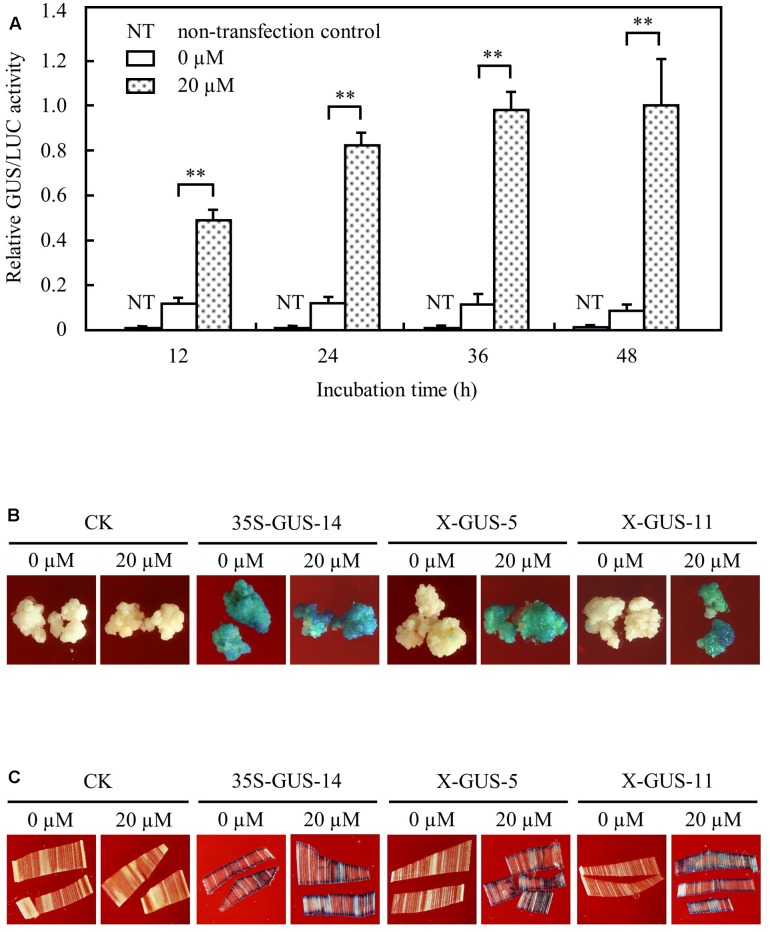
XVE-controlled GUS expression in rice protoplast, calli, and leaf tissues upon direct contact with estradiol. (A) Transient expression assay of XVE-controlled GUS expression in rice protoplasts. Protoplasts transfected with construct pUX-GUS were treated with 0 or 20 μM estradiol for 12, 24, 36, and 48 h, respectively. GUS expressions are represented as relative GUS/LUC activity. ∗∗P < 0.01, t-test. (B) GUS staining of rice calli induced with 0 or 20 μM estradiol. CK, non-transgenic wild type control; 35S-GUS-14, line #14 of rice calli transformed with construct pCAMBIA1305, in which the gus gene was driven by a 35S promoter; X-GUS-5 and X-GUS-11, line #5 and #11 of rice calli transformed with construct pUX-GUS. (C) GUS staining of detached transgenic leaf pieces induced with 0 or 20 μM estradiol.